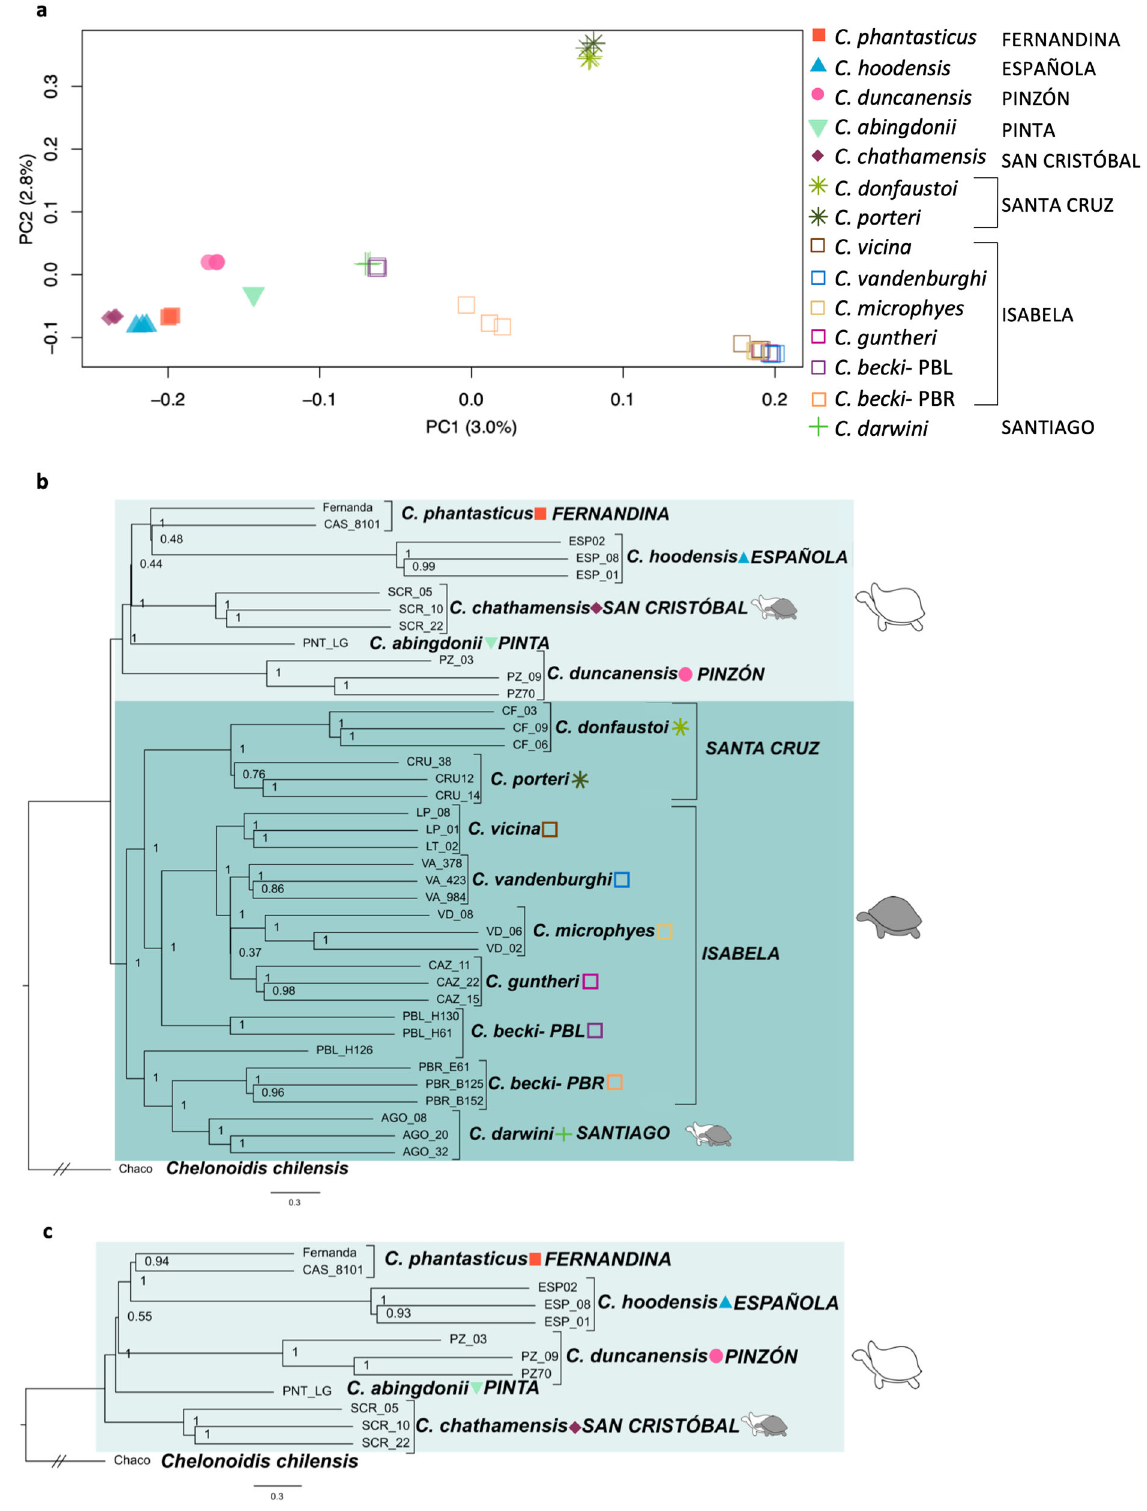
Fig. 2 Genetic relationships among Galapagos giant tortoise species, showing the af fi nity between the two tortoises yet found on Fernandina Island. a Plot of the fi rst two principal components axes. Percentages on the axes correspond to the amount of variation explained by that axis. b Astral consensus tree using 14 species, created from 2331 maximum likelihood RAxML gene trees. The lighter box highlights the clade with predominantly saddleback carapace morphology, the darker box indicates the clade with predominantly domed morphology, the exceptions being the semi-saddlebacked species which are indicated by having both icons next to them. c Astral consensus tree using the predominantly saddlebacked species, created from 2099 maximum likelihood trees. For both B and C, 100 kb segments of the genome were used for the gene trees, each spaced 100 kb apart. Species names are in italics, island names are in capital letters. Values on the nodes indicate posterior